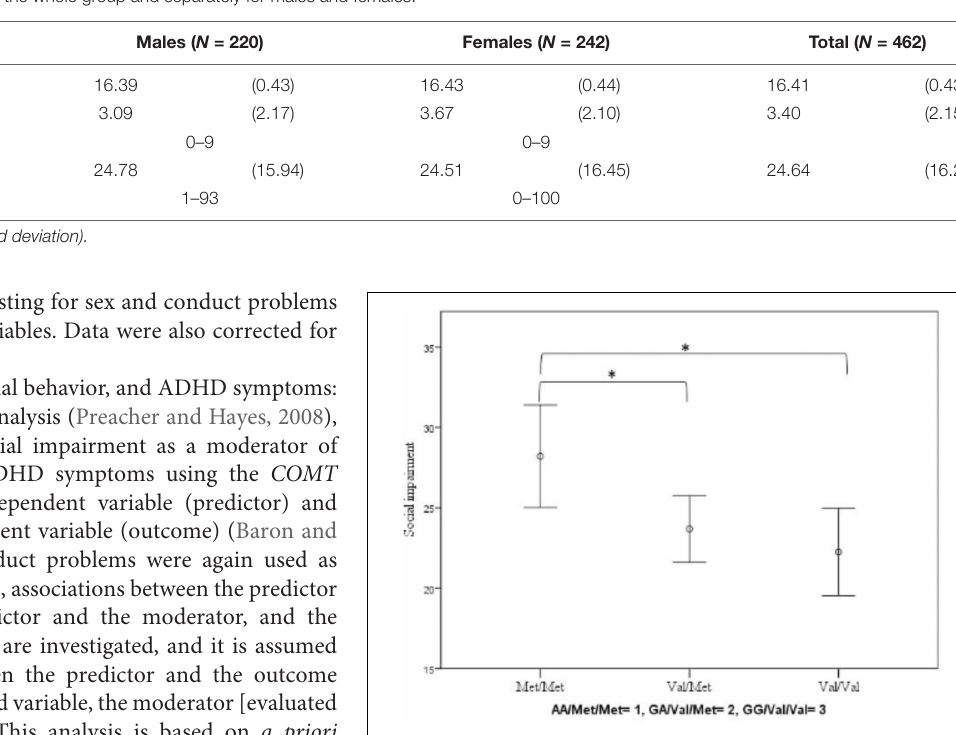
FIGURE 1 | Impact of COMT Val158Met genotype on social impairment measured by the SRS. Means and error bars ± 2 standard errors (SE) are shown. Significant ∗ p <